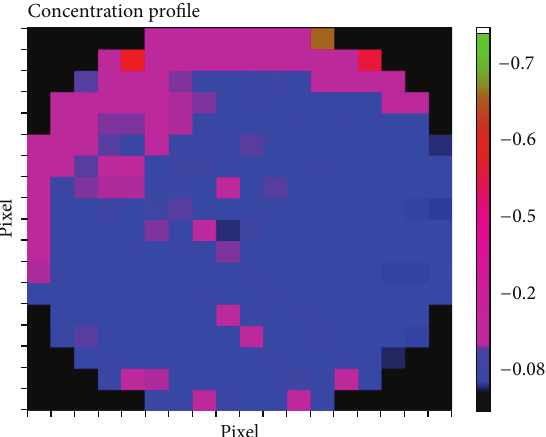
Figure 10: The concentration profile for 25% of air opening.